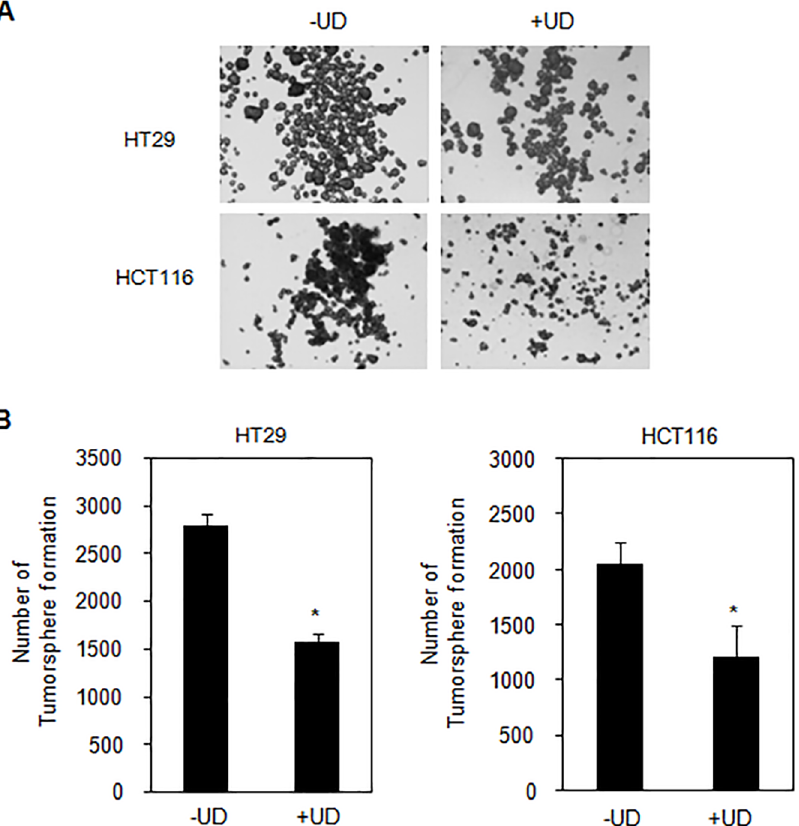
Fig 5. UDCA diminished the number of colon tumorspheres. (A) Representative images of untreatedand 0.2mM UDCA-treated tumorspheres. Images were taken with a 4X objective.(B) Quantification of tumorsphere-formingpotential in untreatedspheresor in spherestreated with 0.2 mMUDCA for 7days. Error bars denotestandard error (n = 3, t < 0.001).